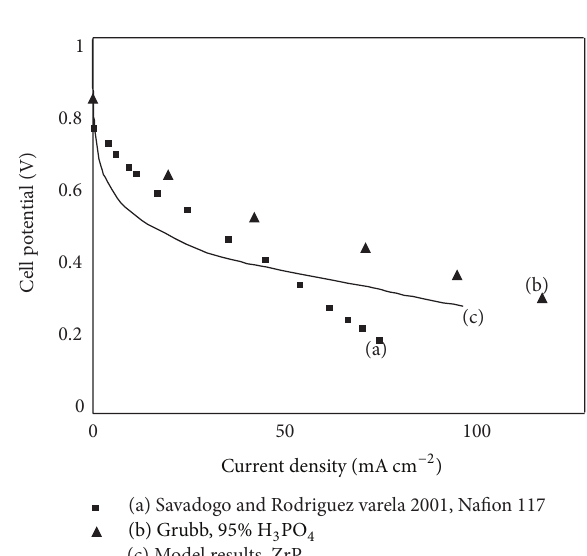
Figure 4: Polarization curves of direct propane/oxygen fuel cell using Pt anode and cathode. (a) Experimental results [31] using Nafion117at95 ∘ C.(b)Experimentalresults[32]using95%H 3 PO 4 at 200 ∘ C. (c) The present proton migration and diffusion model results for a solid ZrP-PTFE electrolyte at 150 ∘